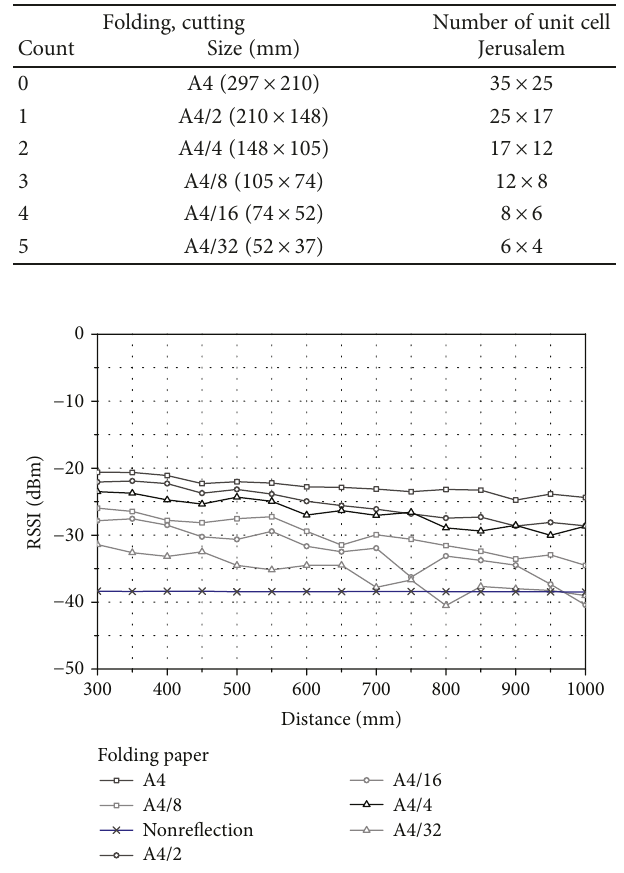
Figure 7: Measurement results of detection distance for folding paper. Table 2: Speci fi cation of security paper tester. Figure 8: Measurement of when a human has security paper: (a) measurement scenario when a human has security paper; (b) measurement results of when a human has security